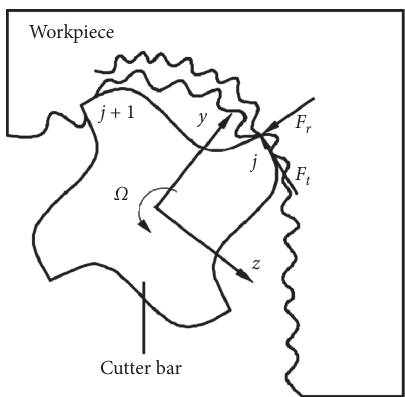
Figure 2: Cross-section view of the cutting